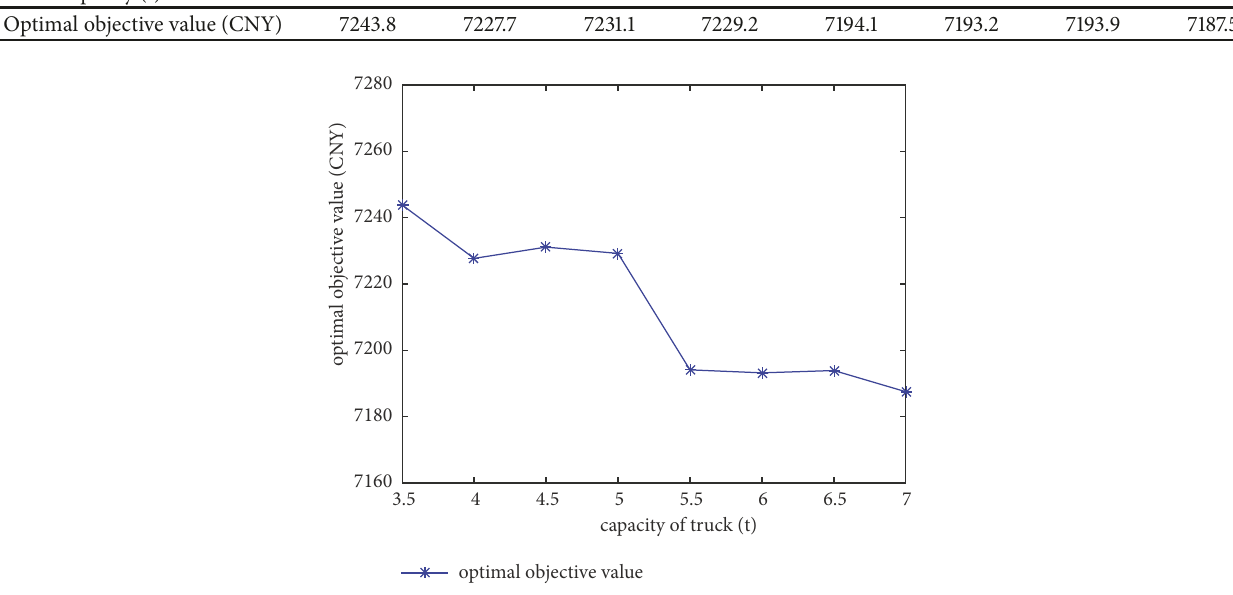
Figure 3: Relationship between the capacity of truck and the optimal objective value.